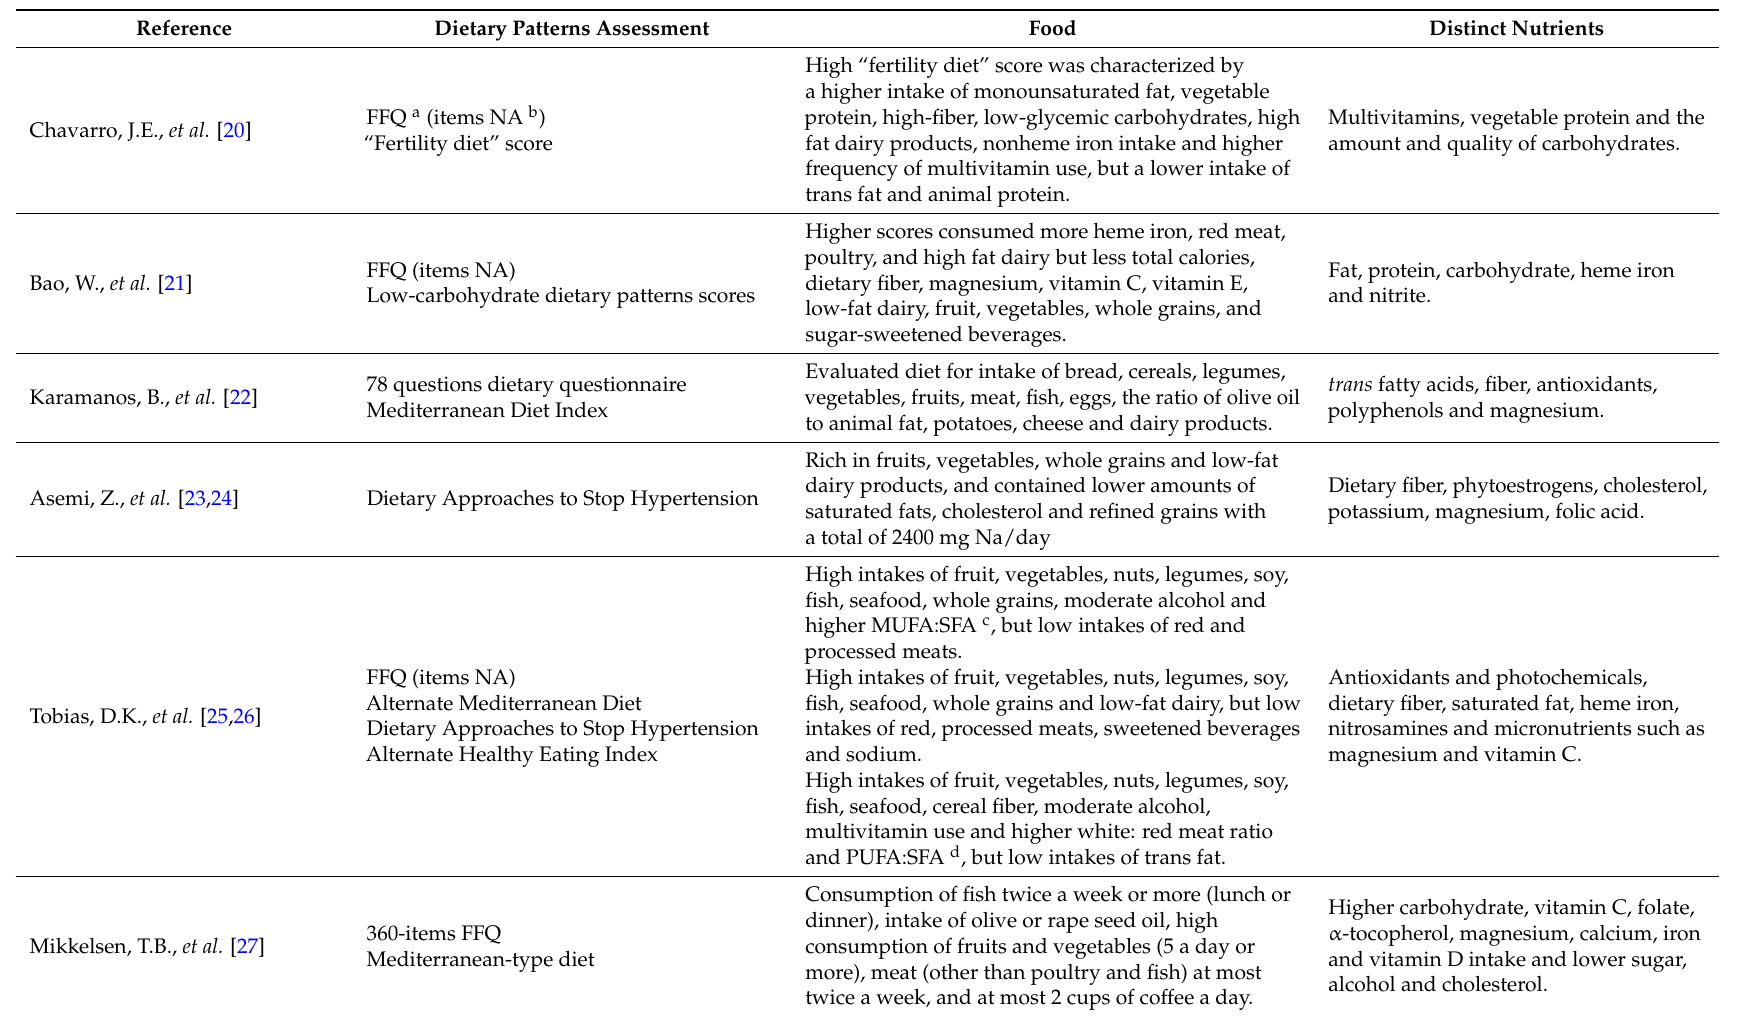
Table 1. Studies reporting dietary patterns based on the popular hypotheses and guidance about the role of nutrients in disease